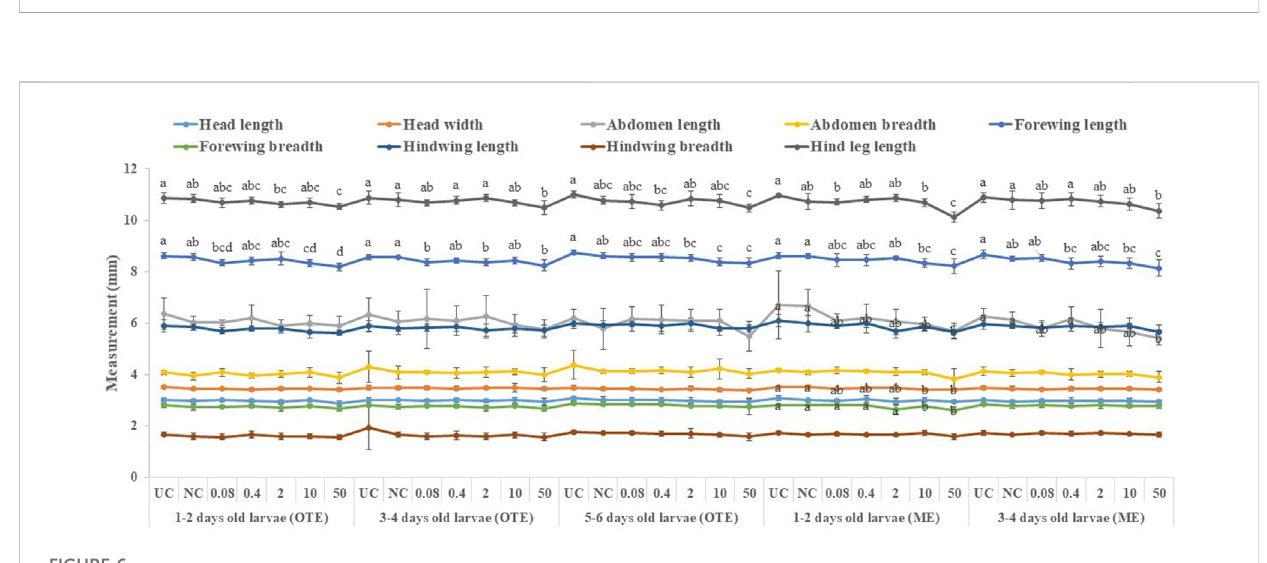
FIGURE 5 Survival of 1 – 2- and 3 – 4-day-old honey bee larvae after ME to difenoconazole. The different letters (a, b ... ) indicate signi fi cant differences by Tukey ’ s HSD ( p < 0.05).